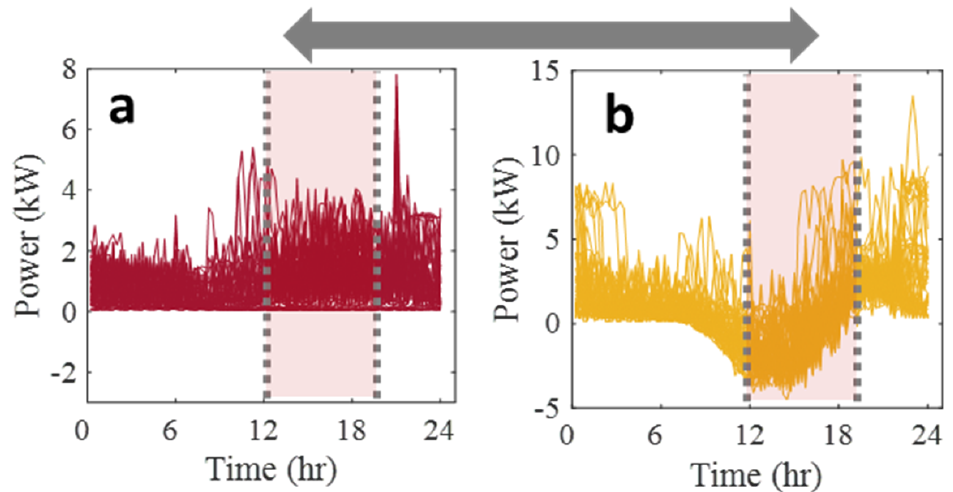
Figure 2. Net demand complementarity for energy trading: ( a ) a consumer’s daily profiles with deficit energy (+ net values), ( b ) a prosumer’s daily profiles with surplus energy ( − net values).